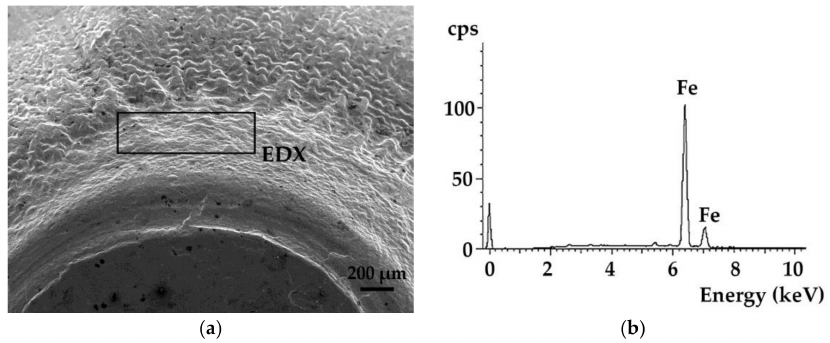
Figure 5. The detailed EDX (energy dispersive X-ray) analysis of the ogive punch surface: ( a ) SEM analyse; ( b ) EDX spectra.